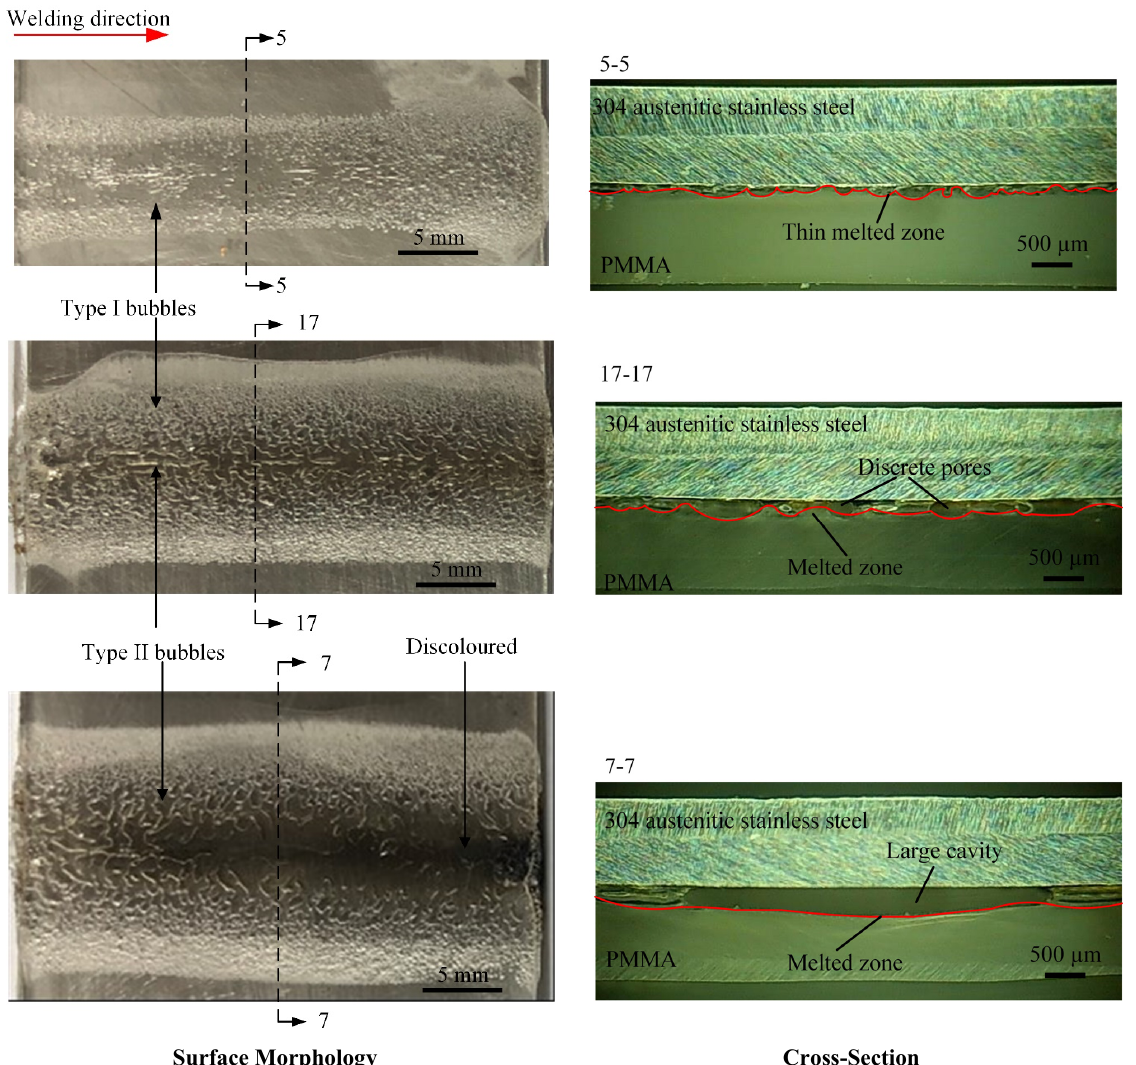
Figure 6. Optical micrographs of the surface morphologies and cross-sections of typical joints of NO.5, NO.17 and NO.7.